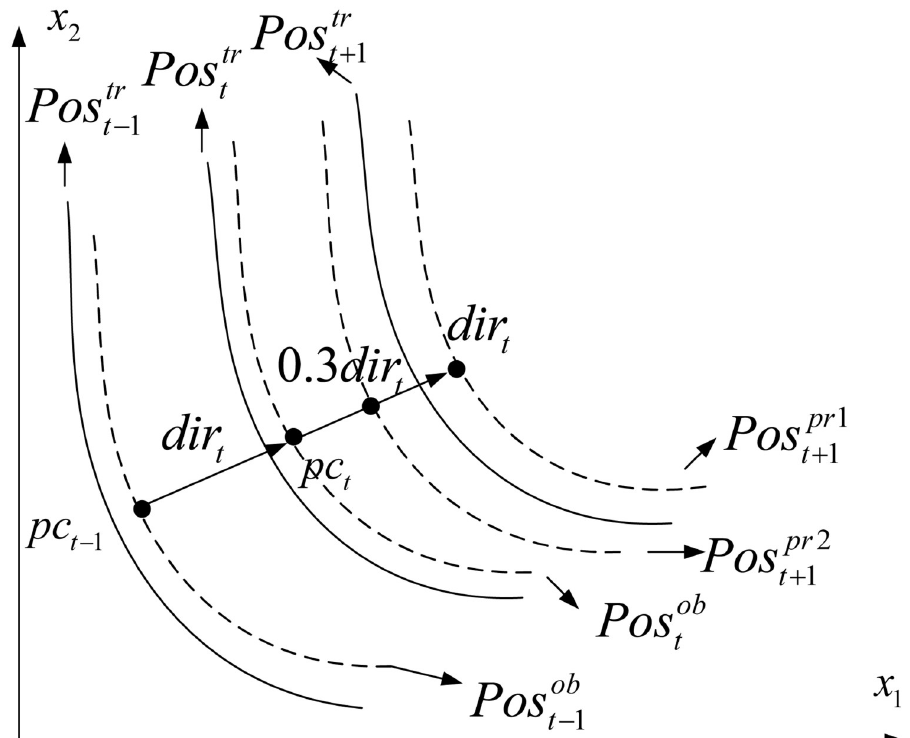
Fig 1. Illustration of linear prediction